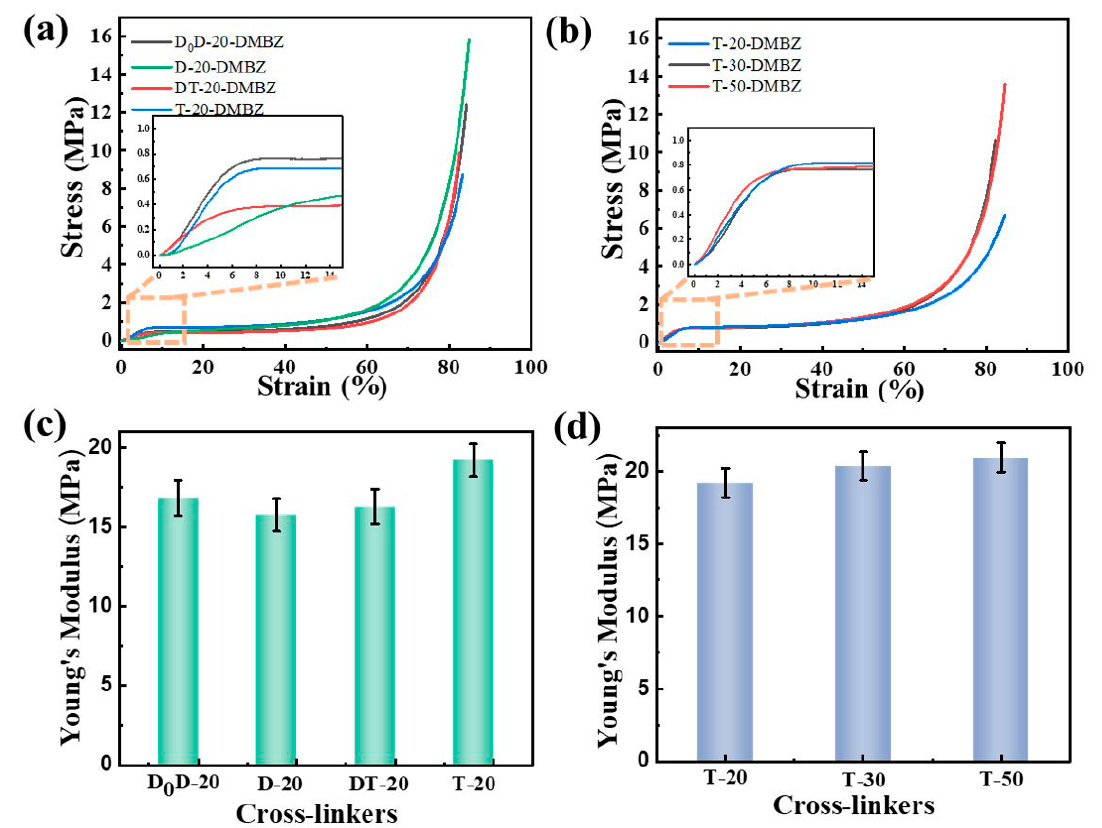
Figure 5. ( a ) Stress–strain curves from compression of polyimide aerogels cross-linked with silicone polymers prepared from different precursors; ( b ) Stress–strain curves from compression of polyimide aerogels prepared with silicone polymers of different degrees of polymerization; ( c ) Young’s modulus of polyimide aerogels cross-linked with silicone polymers prepared from different precursors; ( d ) Young’s modulus of polyimide aerogels cross-linked with silicone polymers prepared with silicone polymers of different degrees of polymerization.